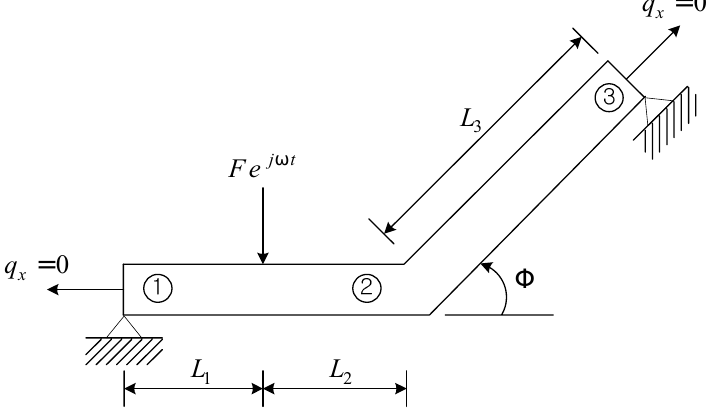
Fig. 3. Two-beam structure coupled with a certain angle Φ and zero intensity boundary